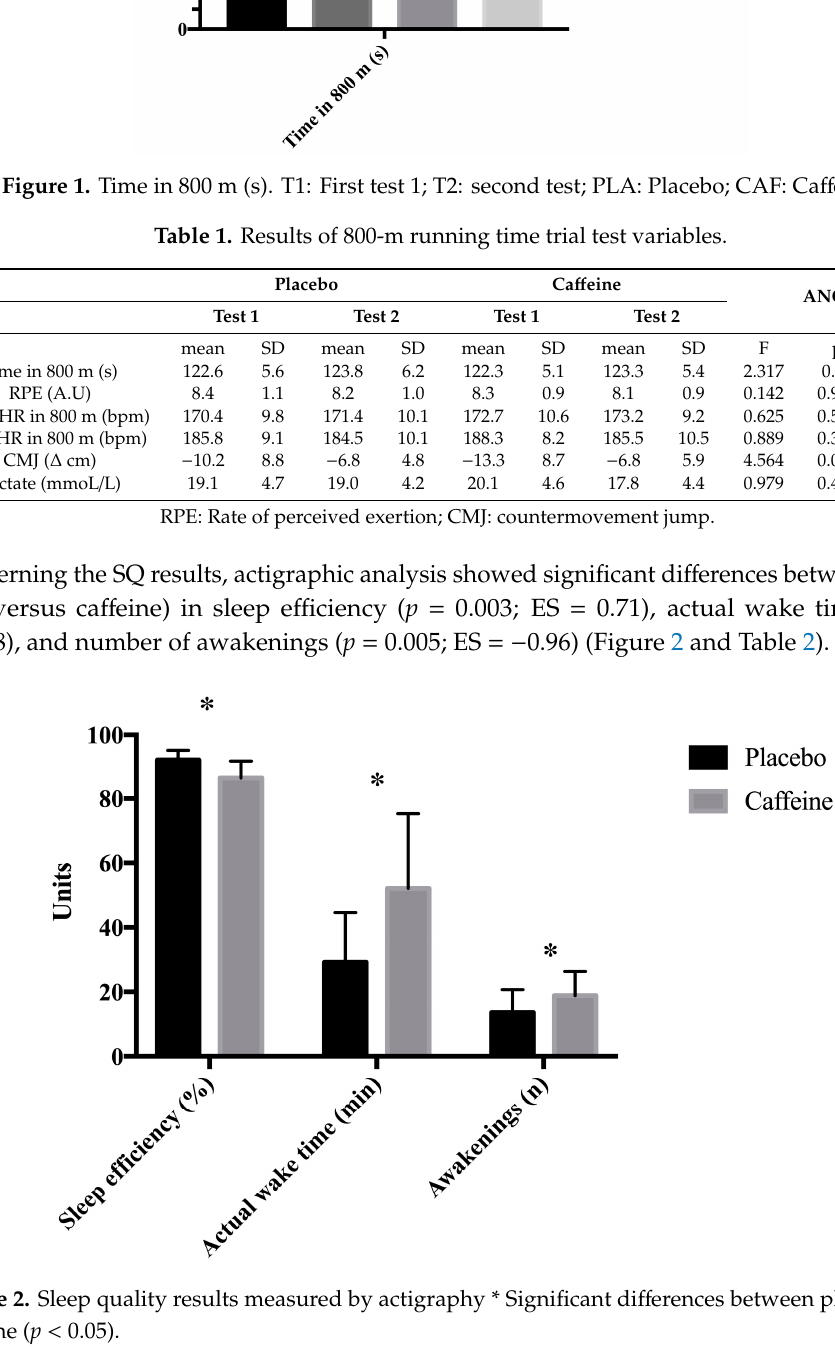
Figure 2. Sleep quality results measured by actigraphy * Significant differences between placebo and caffeine ( p < 0.05).